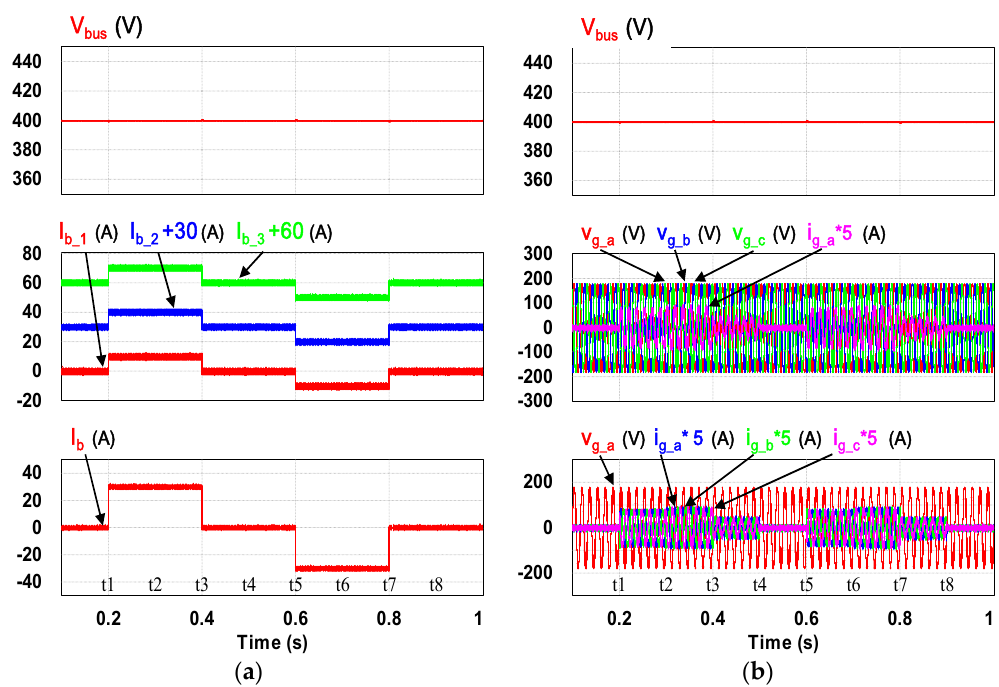
Figure 18. Waveforms of ( a ) interleaved buck-boost converter: DC bus voltage (top), interleaved inductor currents (mid), battery current (bottom) and ( b ) grid-tied inverter: DC bus voltage (top), grid three-phase voltages and a-phase current (mid), grid a-phase voltage and three-phase currents (bottom).